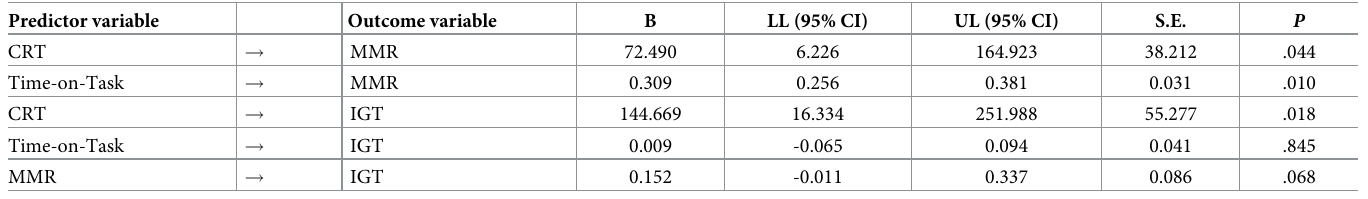
Table 4. Regression weights in the model that included match-making rating (MMR), cognitive reflection task (CRT), and Time-on-task as predictors of perfor- mance in Iowa Gambling Task (IGT). Bootstrapped estimates were used to determine standard error, confidence intervals, and p-values. Predictor